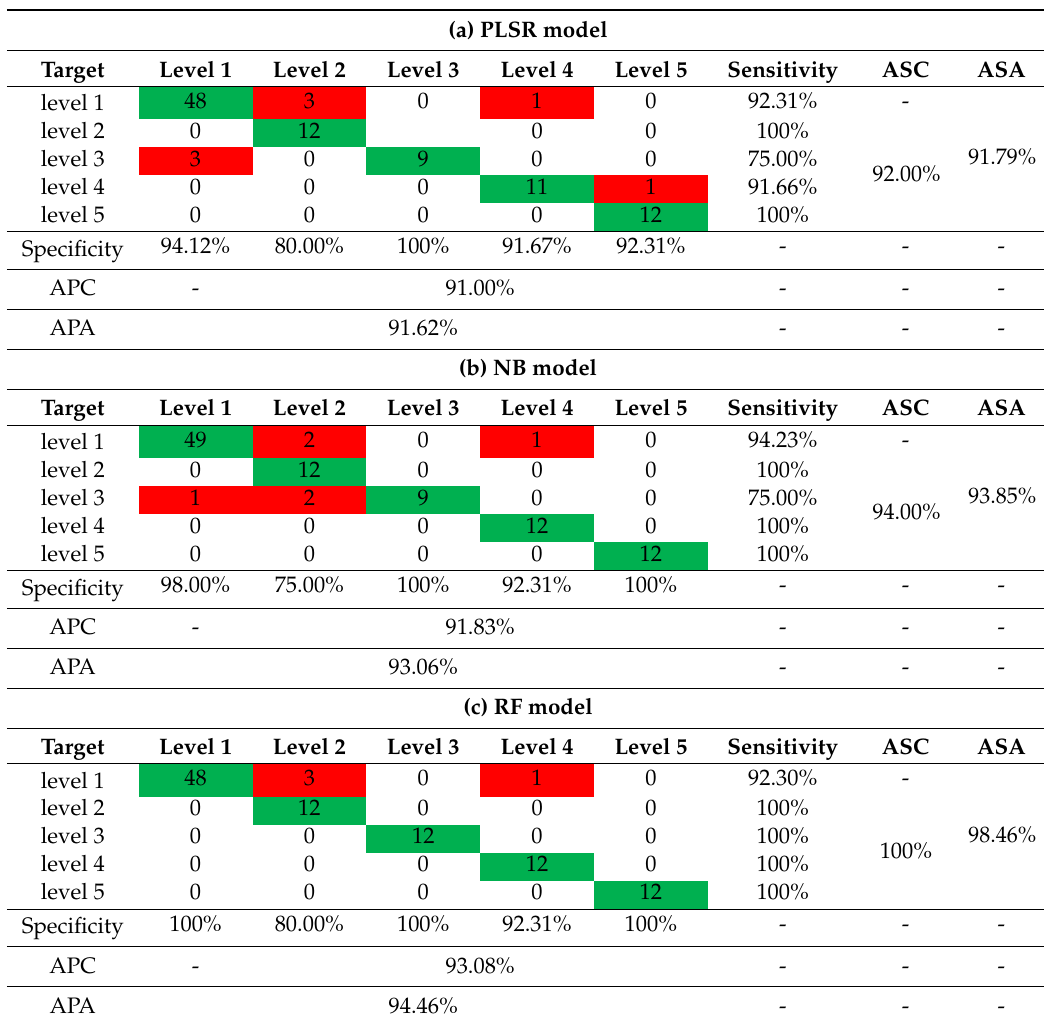
Table 2. Confusion matrix of PLSR, NB, and RF classification for crisp grass carp. ( a ) PLSR. Accuracy of all samples = 92.00%; Accuracy of crisp grass carp samples = 91.67%. ( b ) NB. Accuracy of all samples = 94.00%; Accuracy of crisp grass carp samples = 93.75%. ( c ) RF. Accuracy of all samples = 96.00%; Accuracy of crisp grass carp samples =